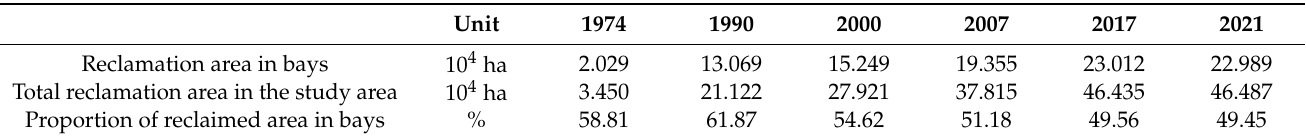
Table 6. Statistics of reclamation areas in bays, the total reclamation area in the study area, and the proportion of reclaimed area in